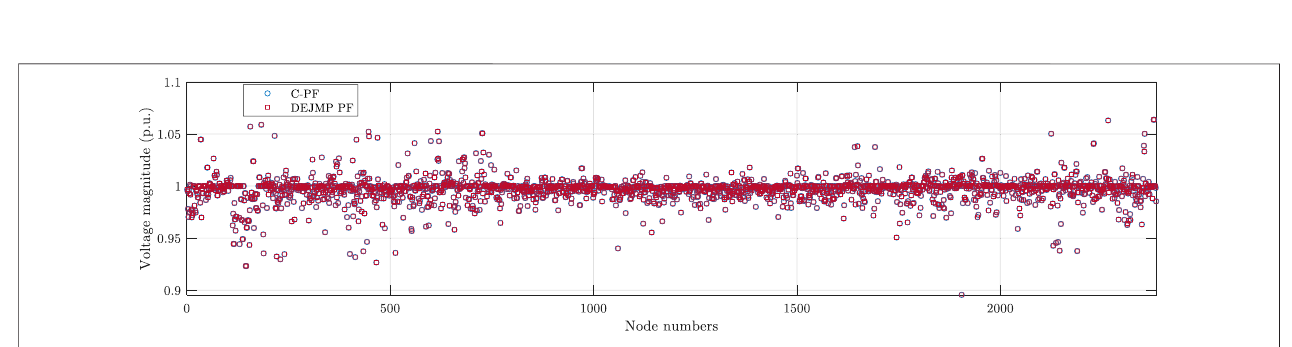
FIGURE 6 | the voltage magnitude obtained by DEJMP-based PF and C-PF on S-2383 bus systems.